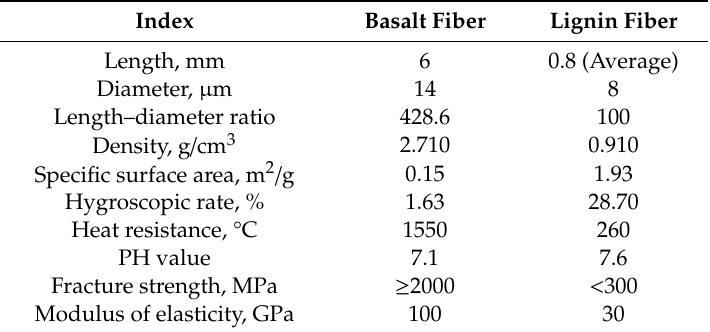
Table 2. Properties of basalt fiber and lignin fiber.